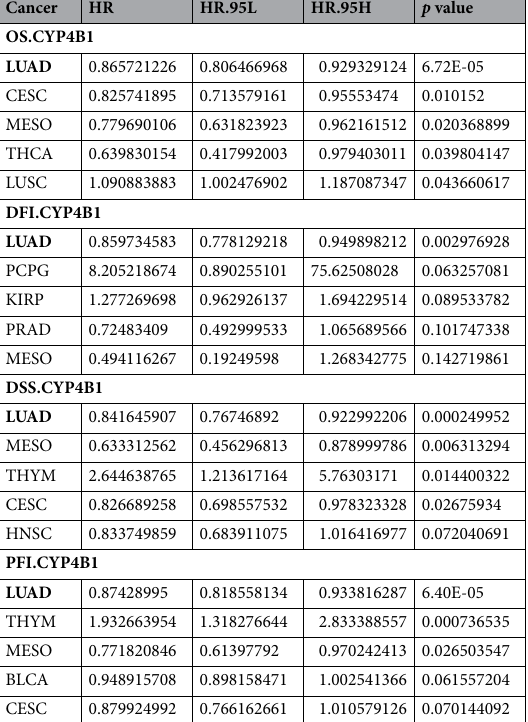
Table 3. Prognostic analysis of CYP4B1.